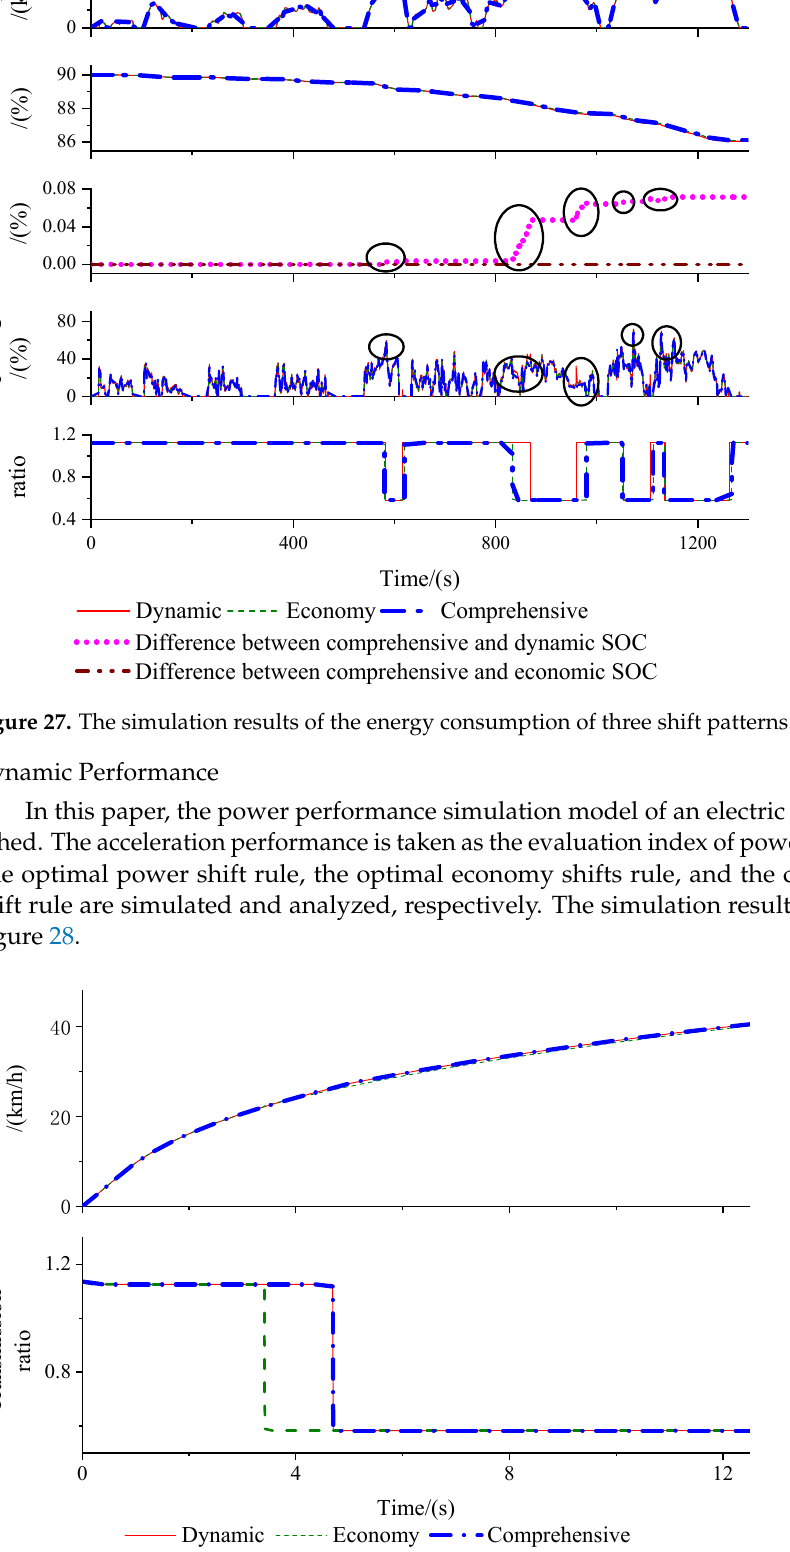
Figure 28. The simulation results of the acceleration performance of three shift rules.